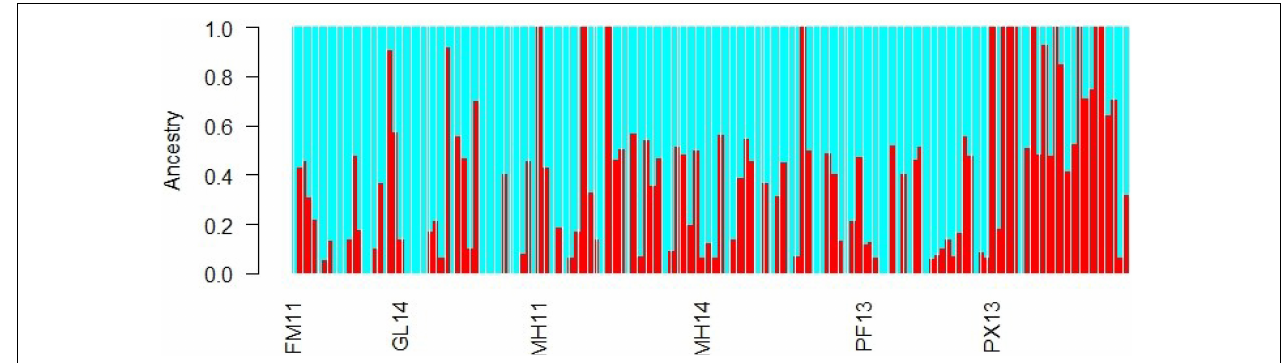
FIGURE 4 | ADMIXTURE bar plot for the spatial and temporal comparisons of samples for k = 2 for LUPS. Bars indicate probability of membership of individuals to each of these sampling locations/years. The probability of membership identifies clusters with similar levels of integrity than scatter plots of Figure 2B . While PX13 sample appears slightly more homogeneous than the remaining samples, no cluster shows lack of admixed genetic